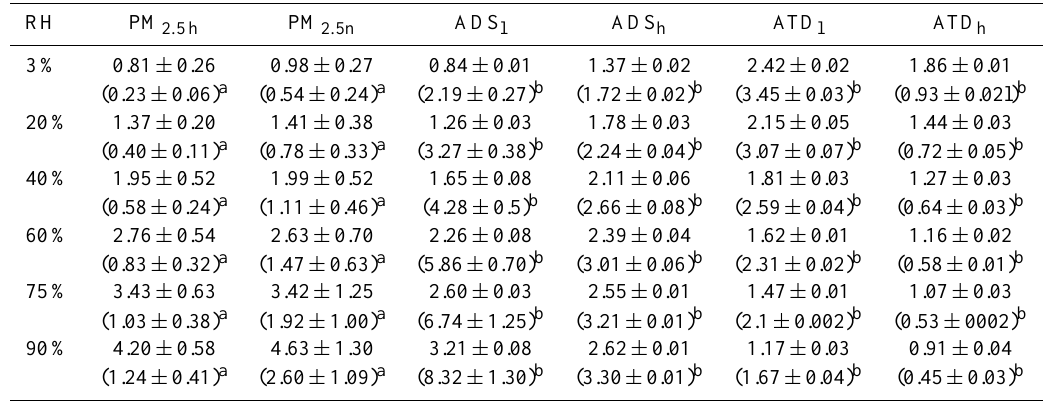
Table 3. The uptake coefficients γ ( × 10 − 4 ) of PAA on PM 2 . 5 , ADS, and ATD under different relative humidity conditions. The values in the parentheses are the lower limit of γ ( × 10 − 5